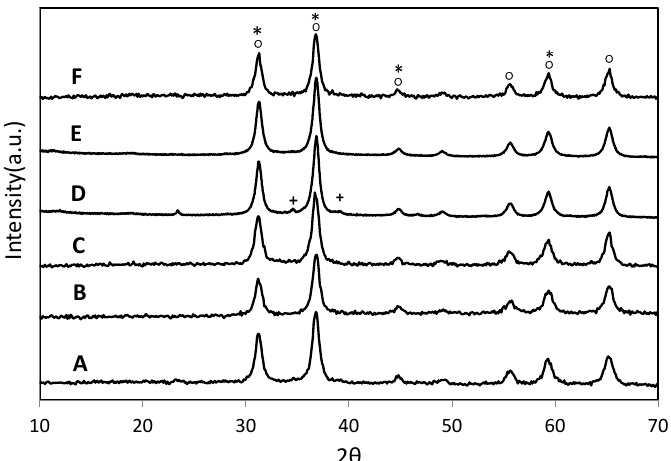
Figure 1. XRD diffractograms of catalysts. (A) ZnAl; (B) Co-ZnAl; (C) Pd-ZnAl; (D) Cu-ZnAl; (E) PdCu-ZnAl and (F) PdCo-ZnAl. ◦ ZnAl 2 O 4 , * Co 3 O 4 and + CuO.